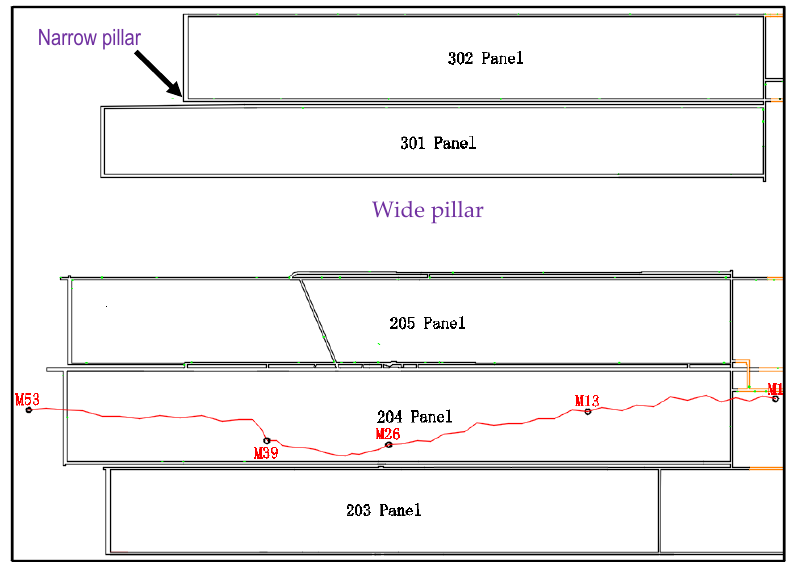
Figure 1. Layout of the longwalls simulated for this study. The layout shows the longwalls separated by narrow pillars in Area 2 (longwall 203 – longwall 205) and Area 3 (longwall 301 – longwall 302). The two areas are separated by a wide coal pillar. The layout also shows the subsidence survey line along the longwall 204.